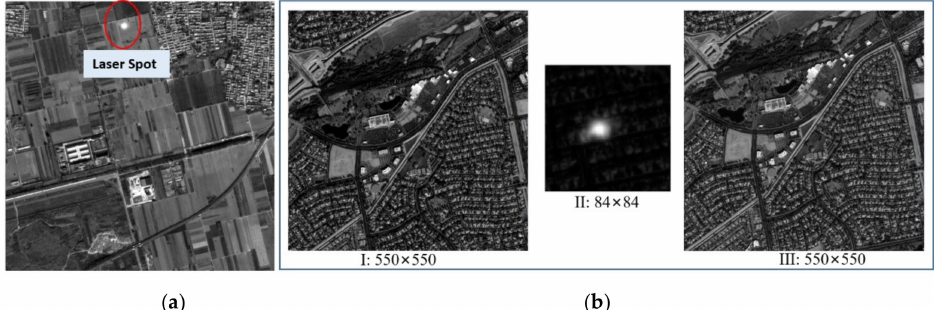
Figure 2. Working mode of the footprint camera. ( a ) Single exposure mode. ( b ) Mode of three